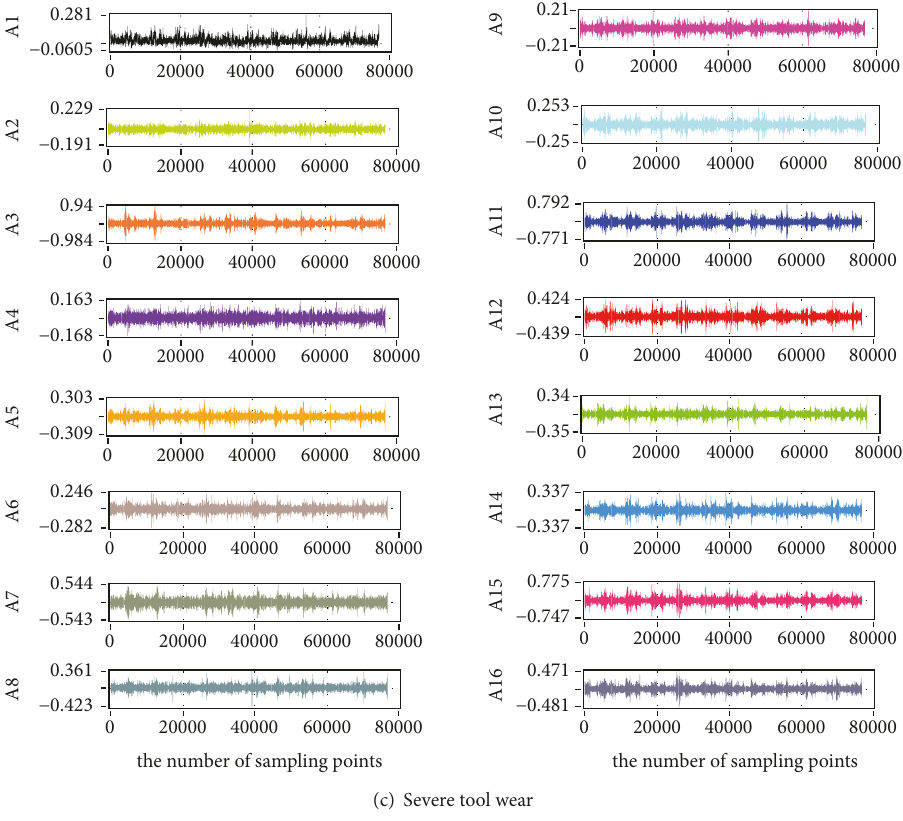
Figure 14: Waveforms of the vibration signal after Wavelet packet decompositions. Table 7: Energy proportion ( × 10 2 ) of AE signal after wavelet decompositions in each frequency band.